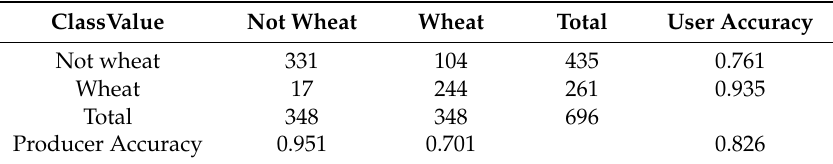
Table 5. Confusion matrix of 2016 wheat classification trained by 2017 data.